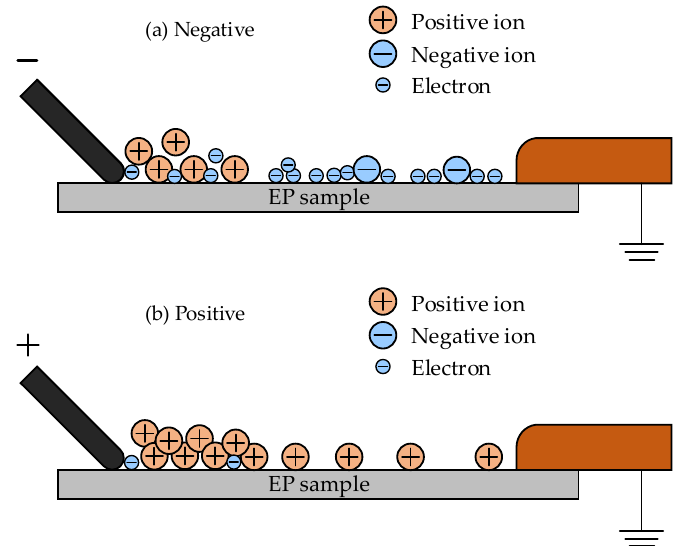
Figure 13. Charge characteristics on the surface at a low pressure with different polarities.